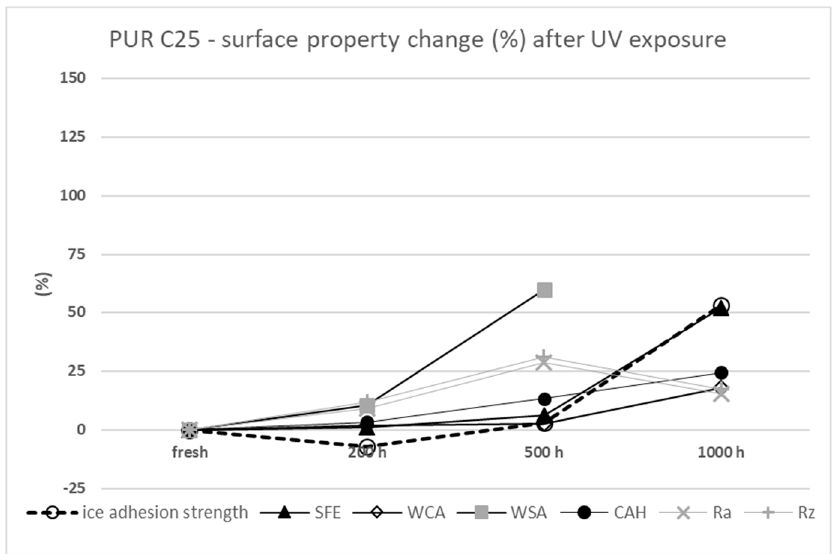
Figure 7. Change in surface properties and ice adhesion strength (%) due to UV(B)-ageing of the coating “PUR C25” (maximum value of y -axis 150%).